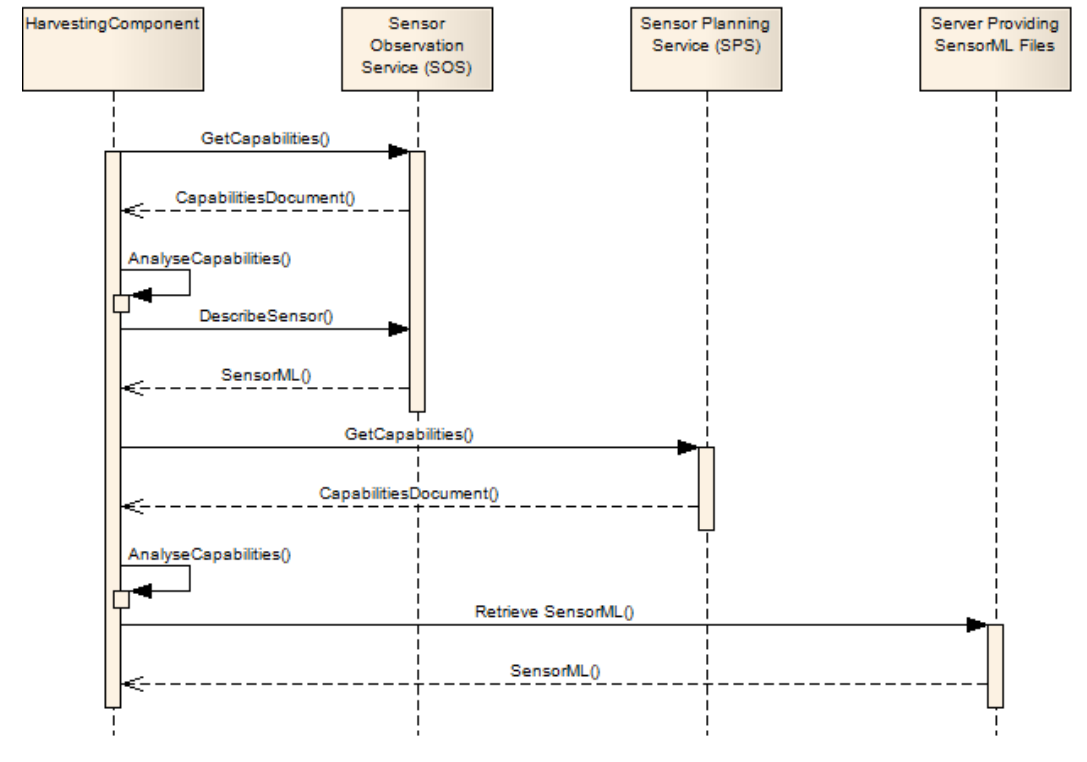
Figure 3. Schema showing of the SIR metadata harvesting